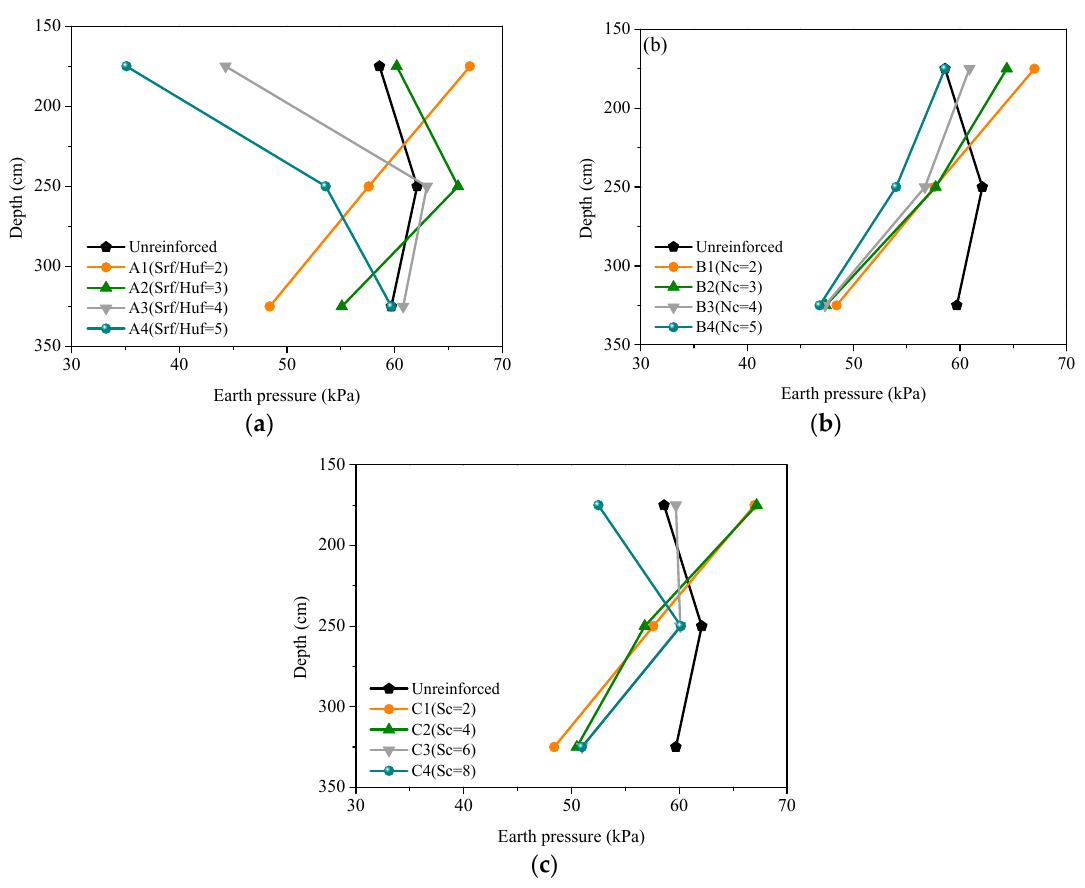
Figure 6. Lateral earth pressure under different reinforced factors: ( a ) embedded ratio; ( b ) number of reinforced layers; ( c ) interval of reinforced layers.